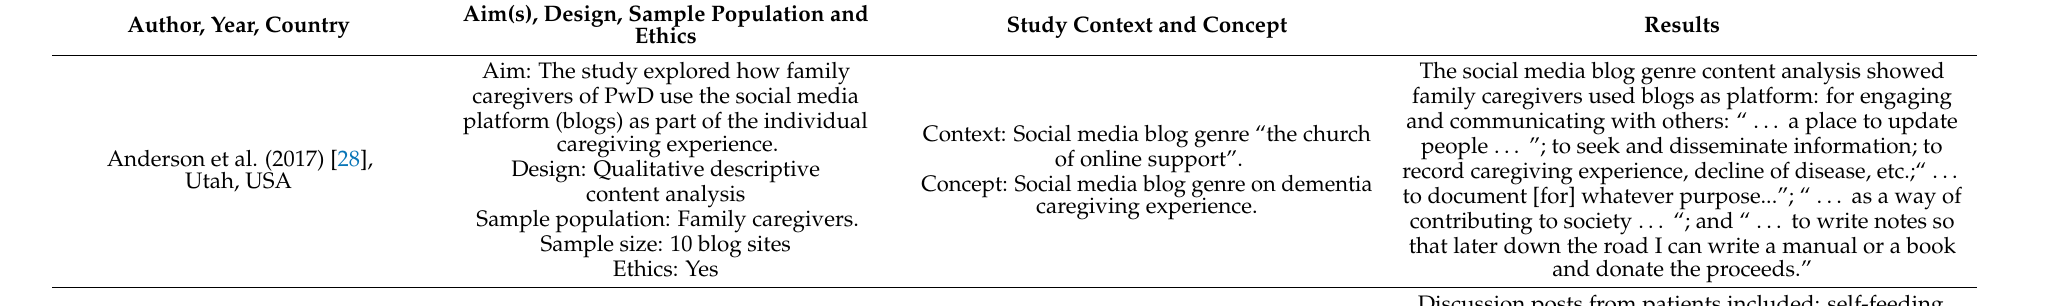
Table 1. Overview of included studies in scoping review for collaborative learning acquisition through virtual Community of Practice in dementia care